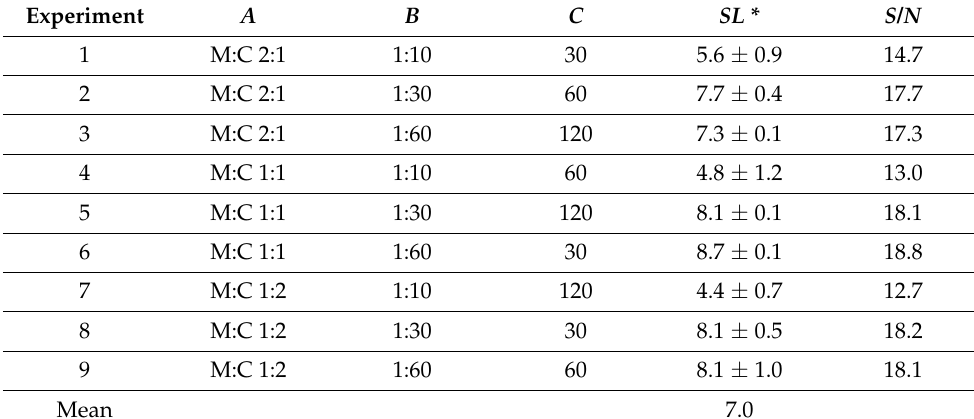
Table 6. Design of experiments using Taguchi orthogonal array and experimental SL and calculated S/N